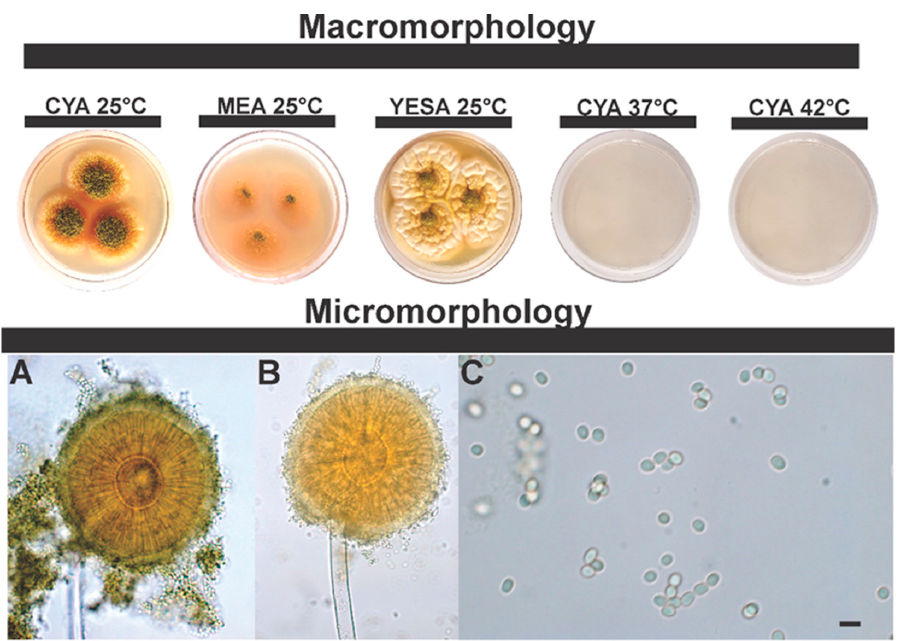
Figure 7. Colonial and microscopic morphology of Aspergillus annui sp. nov. (365-IT-PPK = IBT 36122). ( A , B ) Conidiophores; ( C ) Conidia (scale bar 5 µm).